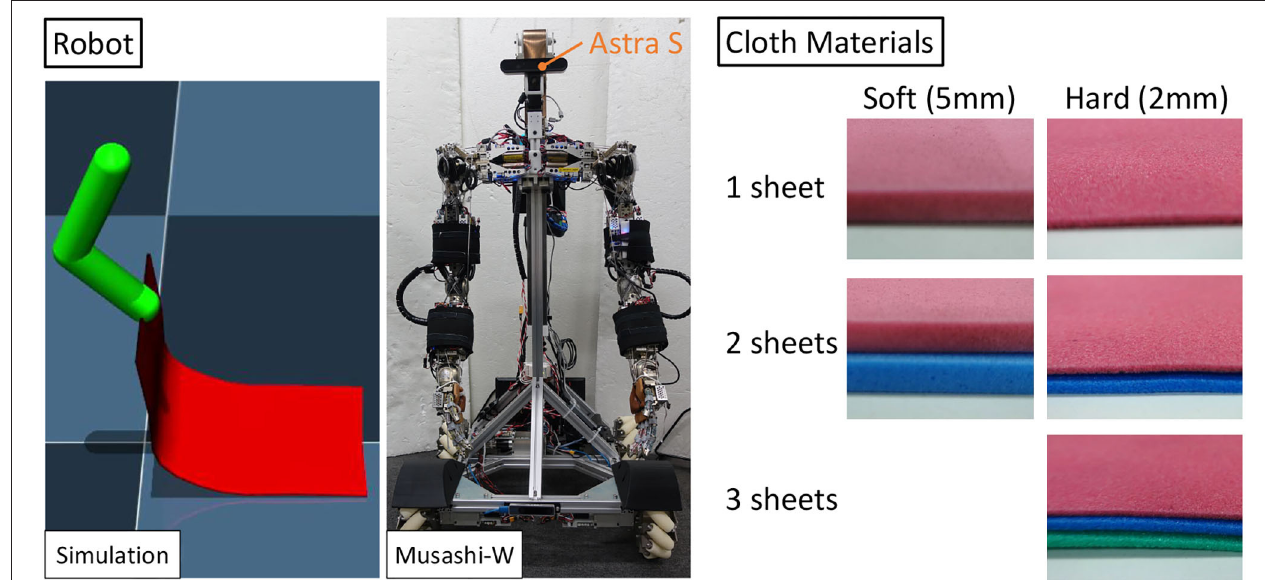
FIGURE 4 | Experimental setup: the simulated simple robot and the musculoskeletal humanoid Musashi-W used in this study and cloth materials of soft and hard type polyethylene